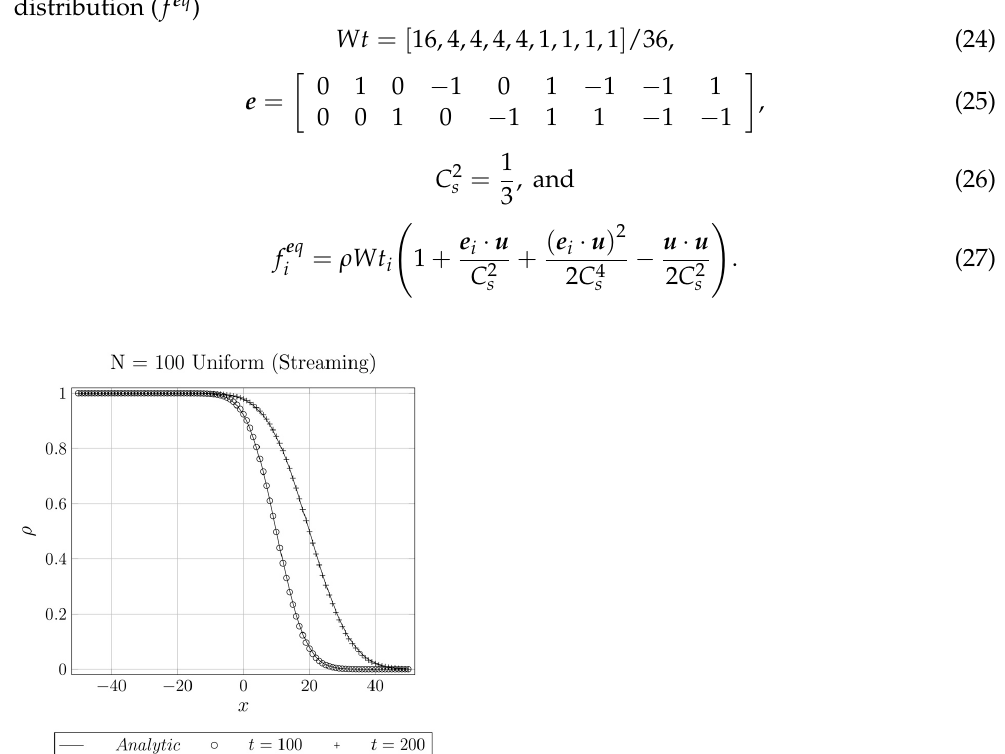
Figure 4. Advection–diffusion problem solved by LBM with regular streaming for 100 uniformly distributed points.